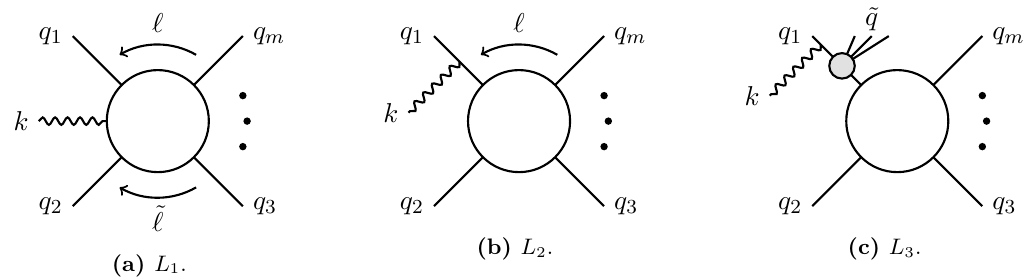
Figure 1 . Classification of one-loop integrals encountered in the calculation of radiative QED amplitudes. The legs that connect to the loop can either be on shell or off